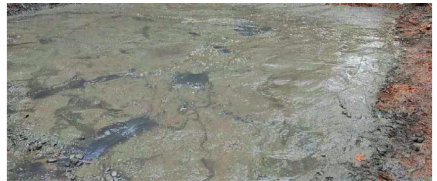
Figure 14: Surface subsidence pit after surface collapse treatment with clay.